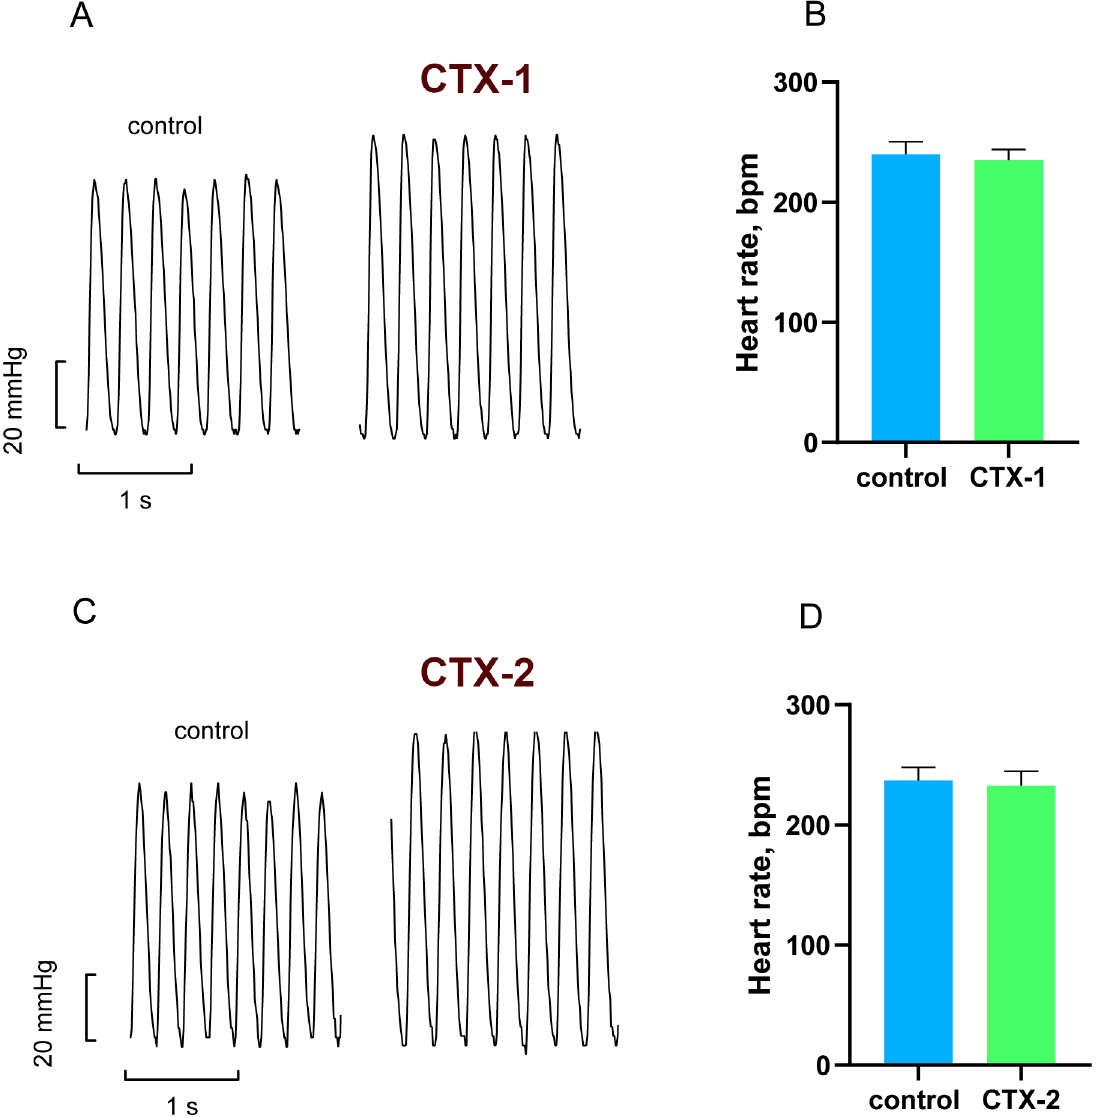
Figure 3. The effects of CTX-1 and CTX-2 at the concentration of 5 μg/mL on the heart rate. Representative traces of the effect of (A) CTX-1 and (C) CTX- 2 on the heart rate. Histograms showing heart rate in (B) CTX-1 (n = 6) and (D) CTX-2 (n = 5) groups. BPM: beats per min. Ten-second intervals were taken at the time when the positive inotropic effect on LVDP was already at its maximum (indicated as CTX-1 and CTX-2) and just before addition of CaTX (control). Data are presented as means ± standard error of the mean. No difference was observed at p < 0.05 by the paired two-tailed Student’s t